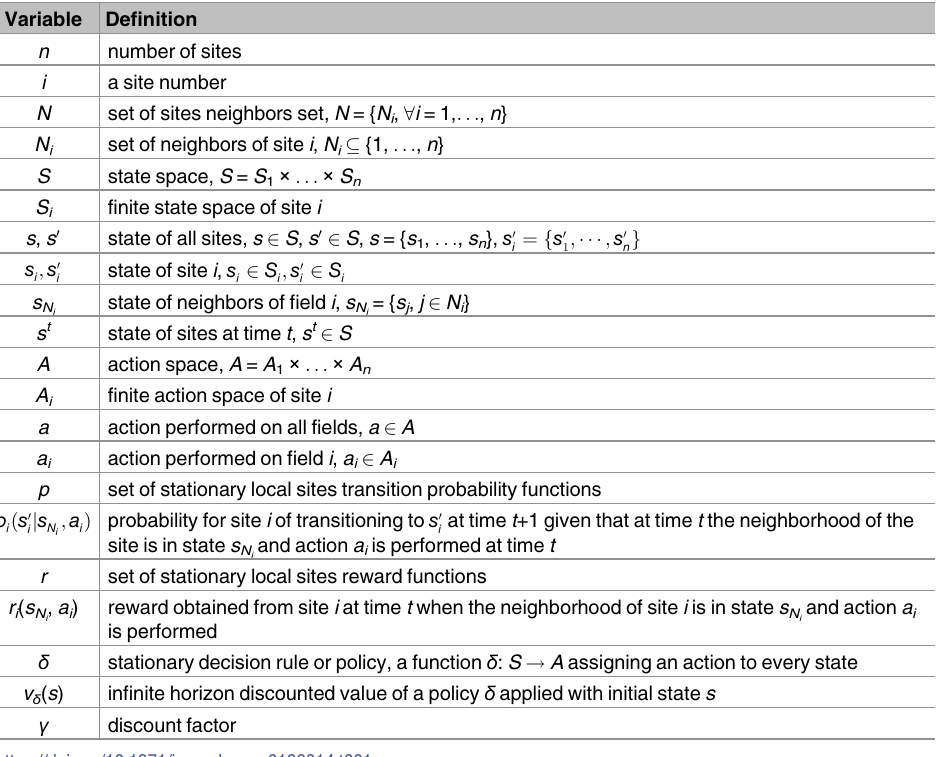
Table 1. Variables related to GMDP